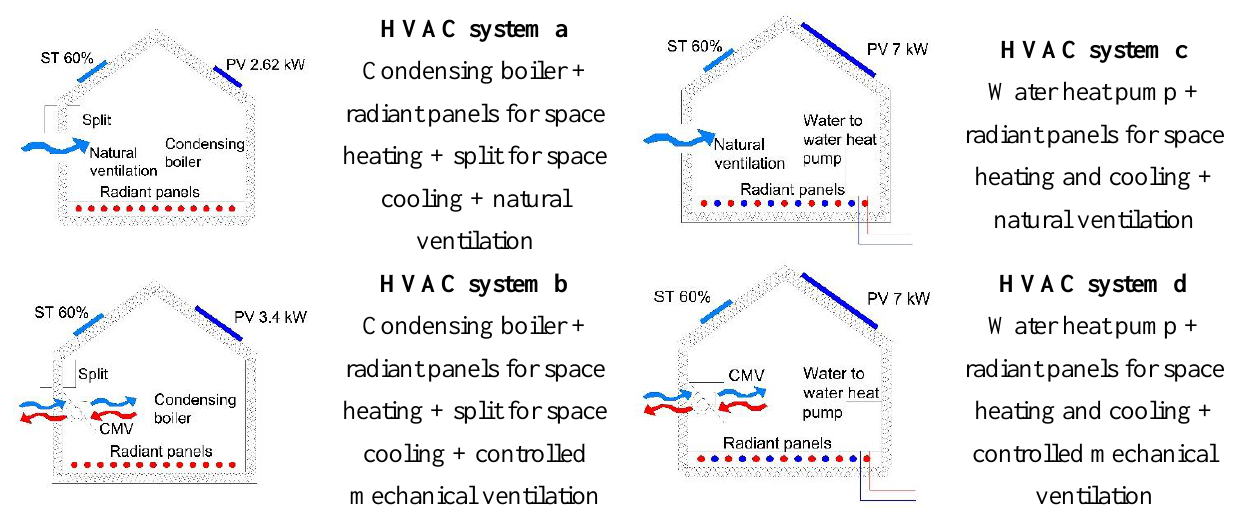
Figure 4. Design configurations for heating ventilation and air conditioning (HVAC) systems. ST: solar thermal panels, PV: photovoltaic panels, CMV: controlled mechanical ventilation. HVAC system a Condensing boiler + radiant panels for space heating + split for space cooling + natural ventilation HVAC system b Condensing boiler + radiant panels for space heating + split for space cooling + controlled mechanical ventilation